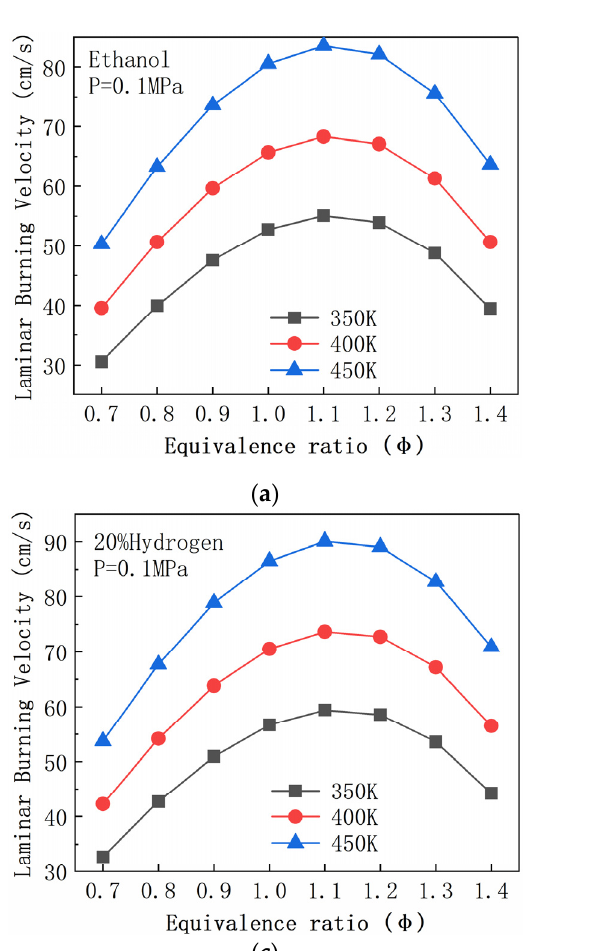
Figure 6. LBVs at different ER as a function of hydrogen composition (T0 = 400 K, P0 = 0.1 MPa).